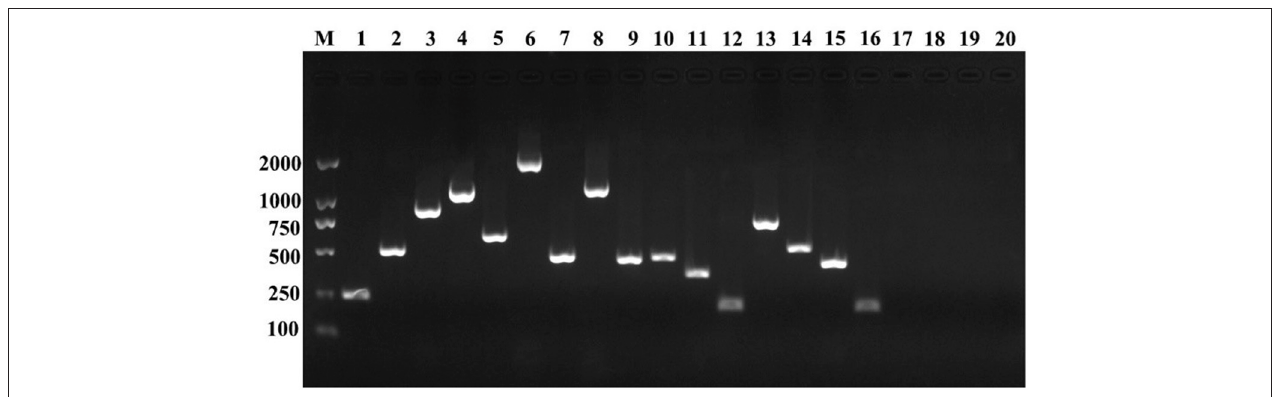
FIGURE 4 | Detection of virulence-related genes of the initial V. anguillarum cells. M, DL 2000; lane 1, emp A; lane 2, vah 1; lane 3, vah 2; lane 4, vah 3; lane 5, vah 4; lane 6, vah 5; lane 7, rtx A; lane8, fla A; lane 9, fla D; lane 10, fla E; lane 11, vir C; lane 12, ton B; lane 13, mre B; lane 14, tox R; lane 15, rpo S; lane 16, fts Z; lane 17, ang M; lane 18, ang R; lane 19, vir A; lane 20, vir